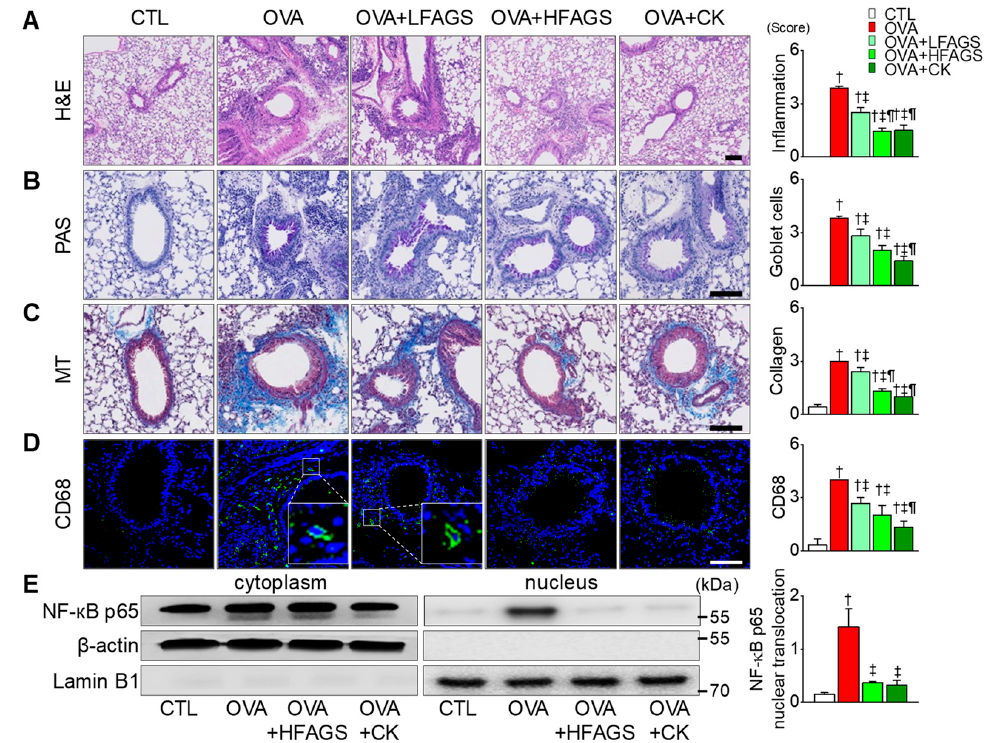
Figure 4. Inhibitory effects of FAGS and CK on OVA-induced allergic airway inflammation in lung tissue. ( A ) Representative images of H&E staining showing infiltration of inflammatory cells. ( B ) PAS staining performed to detect mucus-secreting goblet cells (PAS staining-positive cells). ( C ) Masson’s trichrome (MT) stains showing collagen-fiber deposition (blue). ( D ) CD68-positive cells (green). ( E ) Detection of NF- κ B p65 in cytoplasmic and nuclear fractions. Bar graphs show summarized scores of inflammation ( A ), goblet cells ( B ), collagen-fiber deposition ( C ), macrophage accumulation ( D ), and NF- κ B p65 nuclear translocation ( E ) in each experimental group. Scale bars, 100 µ m. Data are shown as mean ± SE (each group n = 5). † p < 0.05 compared with CTL. ‡ p < 0.05 compared with OVA. ¶ p < 0.05 compared with LFAGS.